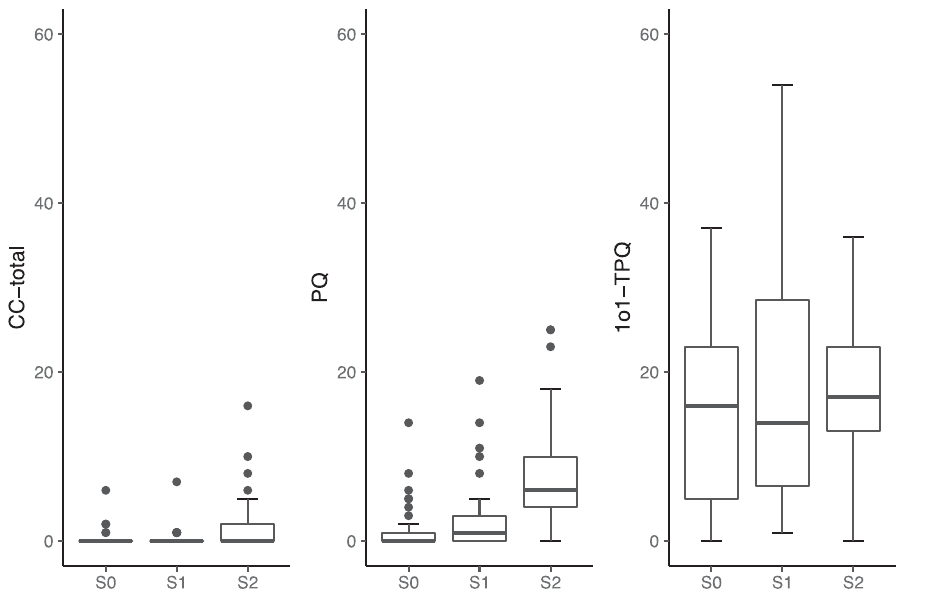
FIG. 6. Frequencies of questioning-related skills across semesters with different numbers of simulator sessions. CC-total is statistically significant with a medium effect size; PQ is statistically significant with a large effect size; 1o1-TPQ is not statistically significant. For both CC-total and PQ, the frequencies in semester 2 are higher compared to both semester 0 and semester